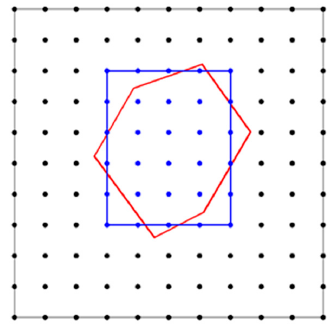
Figure 10. Illustration for a minimum rectangular box (the blue color) that contains all the points to be placed in the trial placement aggregate (area surrounded by the red color lines).